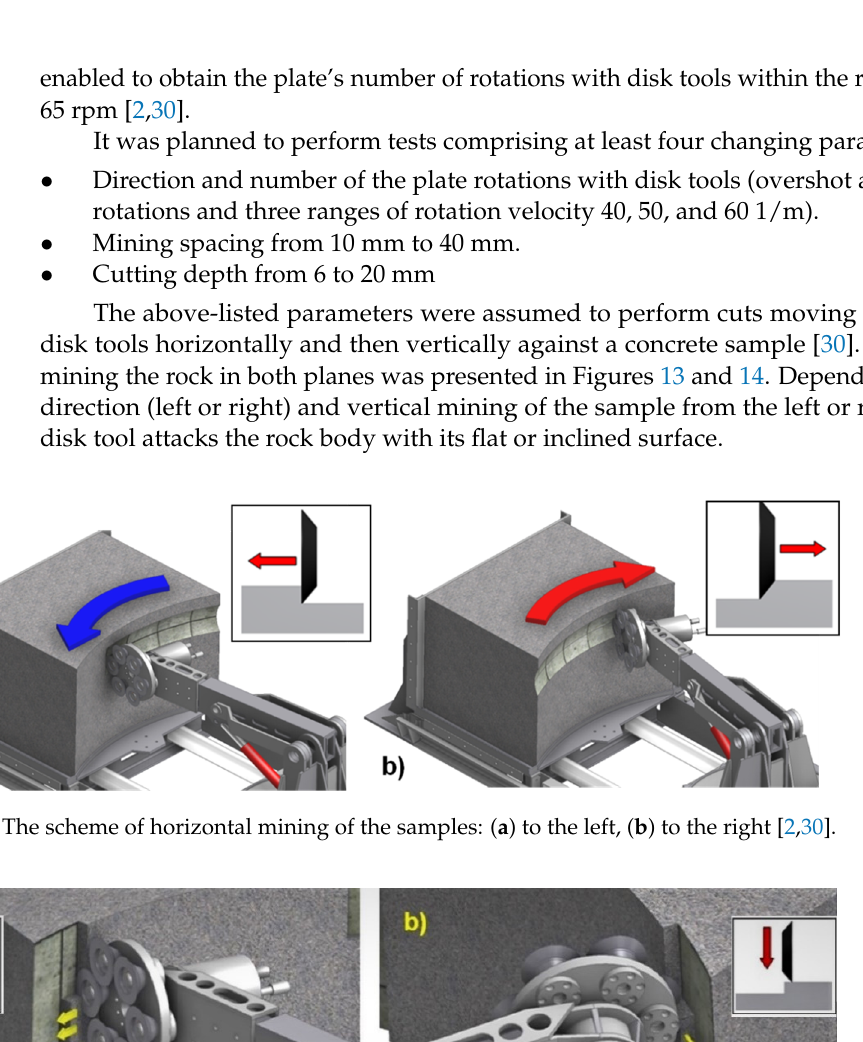
. Figure 14. The scheme of vertical mining of the sample: ( a ) from left edge, ( b ) from right edge